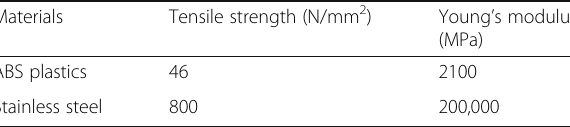
Table 2 Mechanical proprieties of